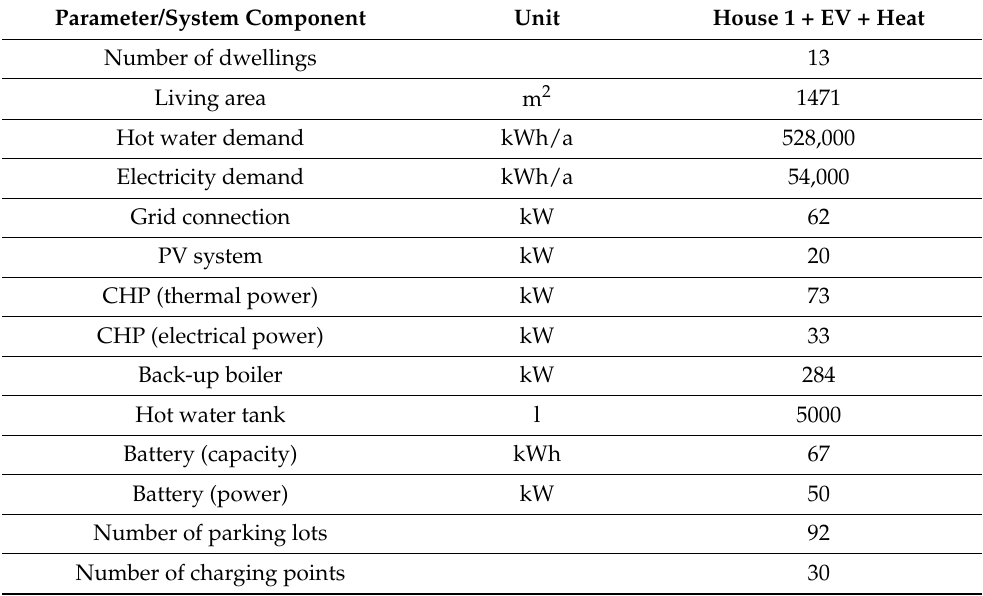
Table 2. Overview of considered system scenarios in the building block. The considered battery operation strategies either maximise self-consumption (max. SC) or minimise the peak load on the grid connection (min. PL).